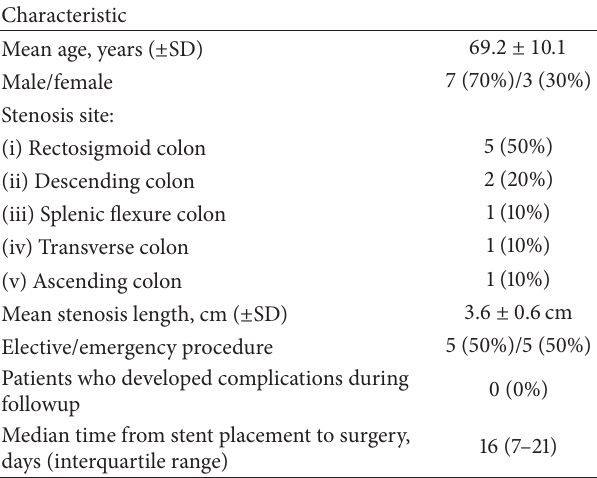
Table 1: Patient demographic and clinical characteristics, and SEMS